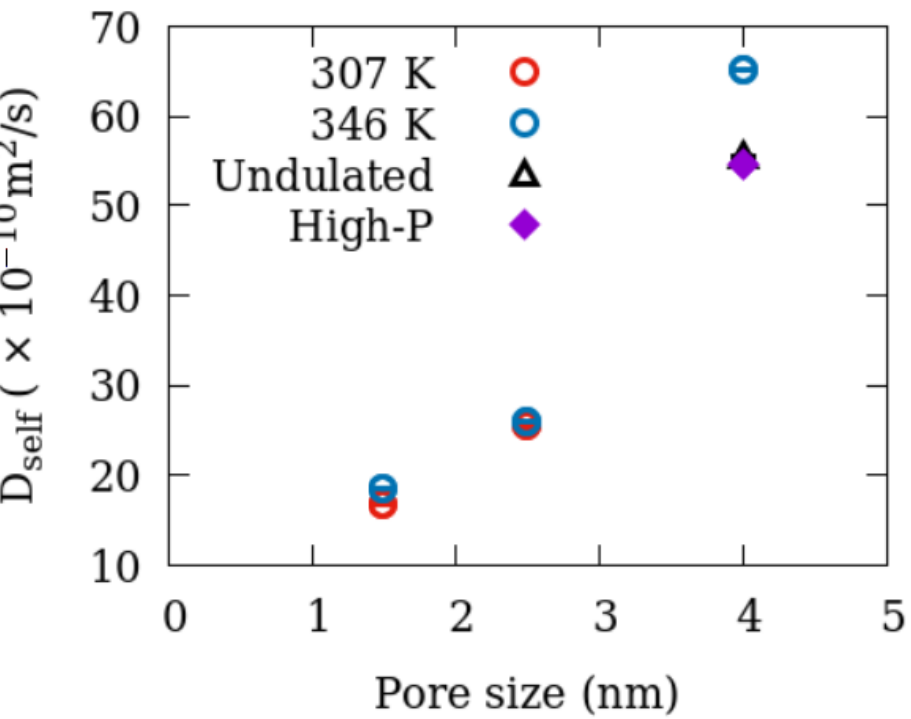
Figure 7. Self-diffusion coefficient of methane in the cylindrical pores of amorphous silica obtained from the simulations. All data in the 4 nm pore were obtained at 346 K.